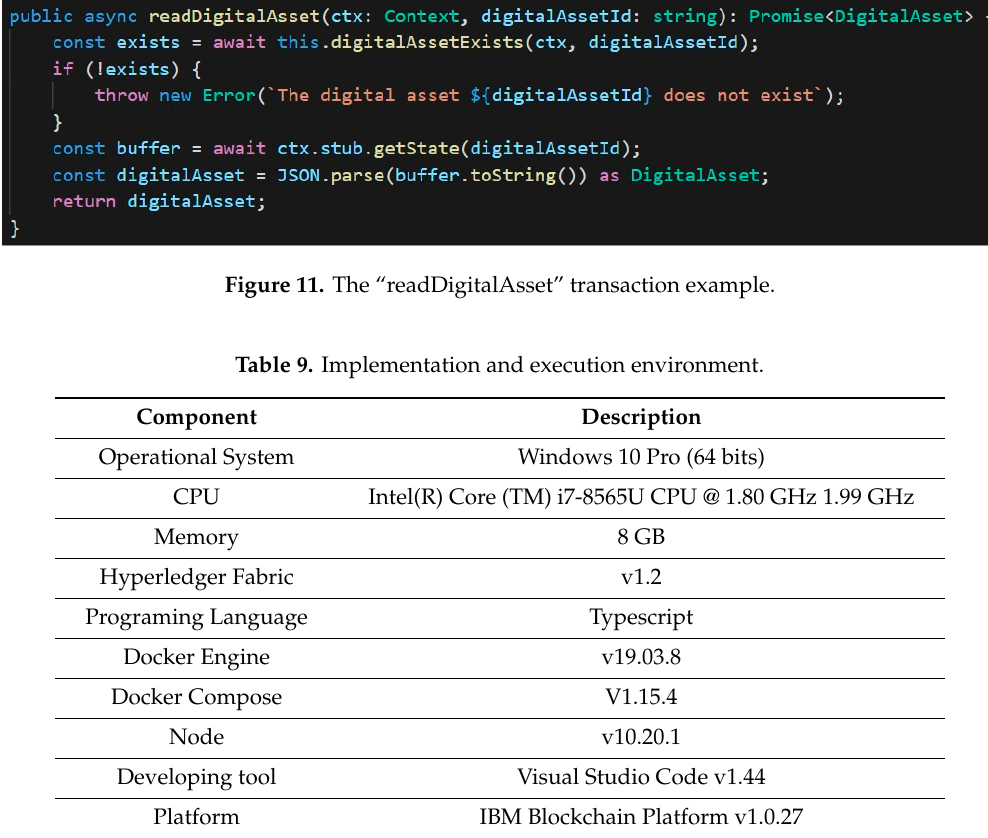
Table 9. Implementation and execution environment.